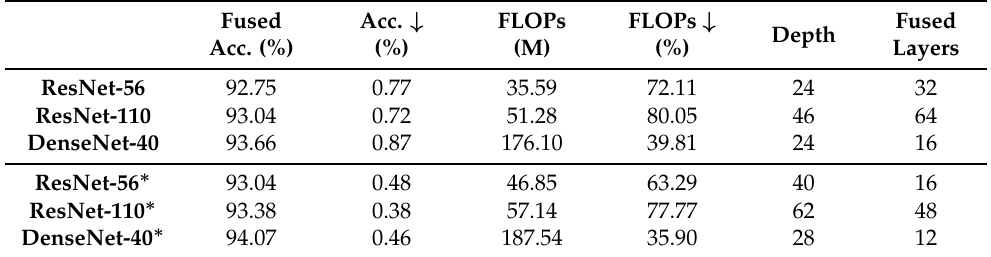
Table 2. Results of layer fusion on CIFAR10. The depth and fused layers refer to numbers of convolutional layers. ResNet-56 ∗ indicates the layer fusion results of the priority selection according to the precision, and same for ResNet-110 ∗ and DenseNet-40 ∗ .